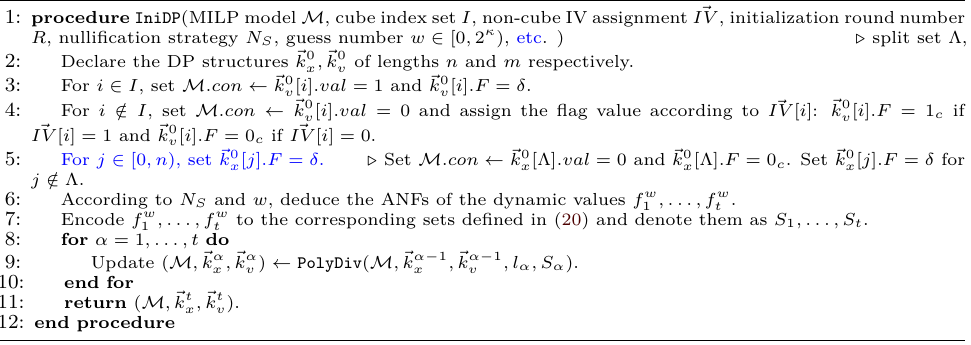
Algorithm 2 The division property of initial key and IV